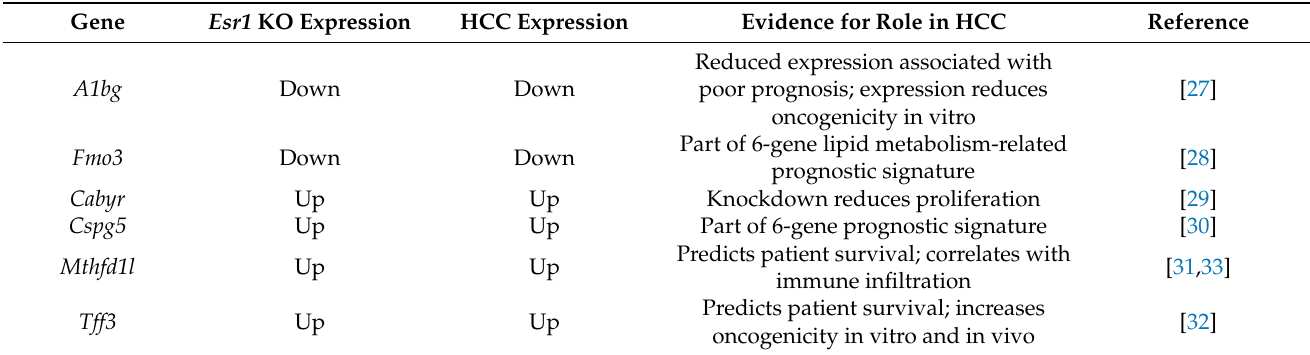
Table 4. Esr1 -regulated genes implicated in hepatocarcinogenesis.